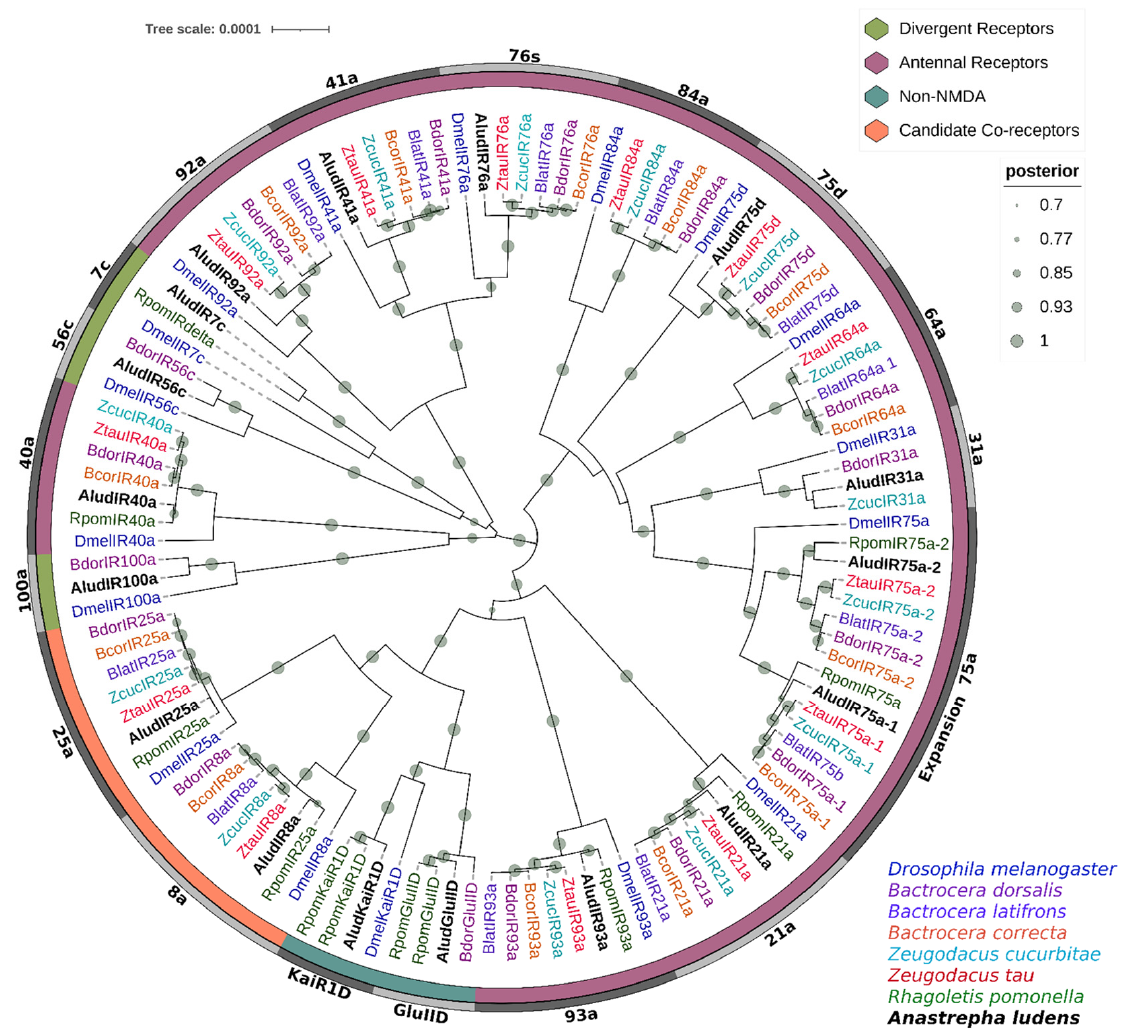
Figure 7. Bayesian phylogenetic analysis of candidate iGluRs/IRs from Anastrepha ludens with homologs from seven Tephritidae species and Drosophila melanogaster . Distinct colors represent clusters of AludIRs members based on putative functions reported in previous studies. Gray bars delimit the branch expansions of the AludIRs and their orthologues. Circles showed posterior probability values higher than 70%.